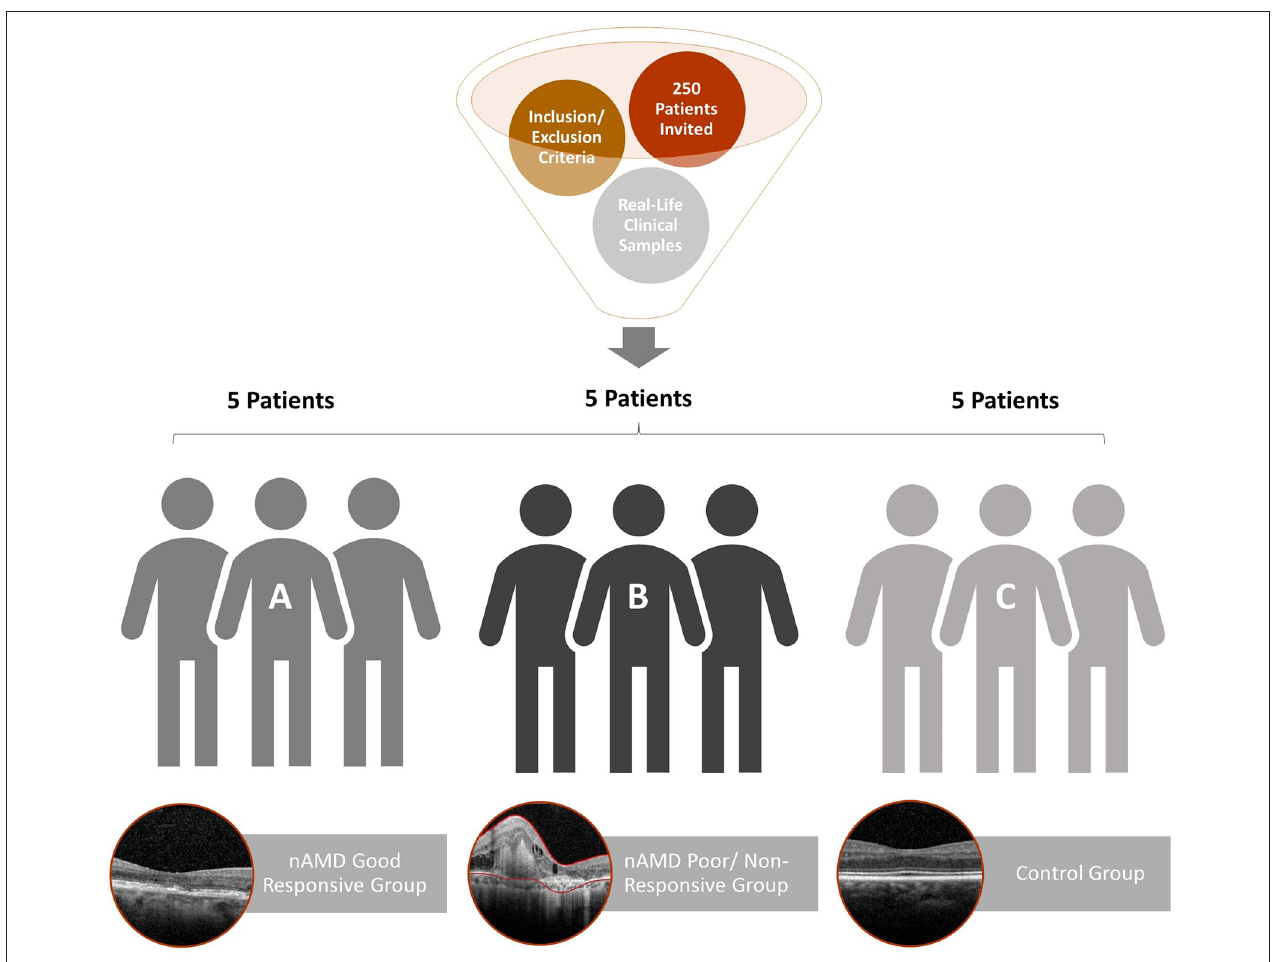
FIGURE 1 | Flowchart of patient recruitment and exclusion for aqueous humor proteome analysis. The 15 patients selected were separated into three groups: (A) good response to anti-VEGF therapy (nAMD good responsive); (B) resistance to anti-VEGF therapy (nAMD poor/non-responsive); (C) control patients without systemic diseases or signs of